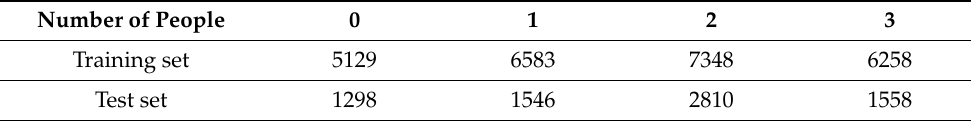
Table 4. Data sets used: the number of frames with N people present in them, N ∈ { 0,1,2,3 } . Number of